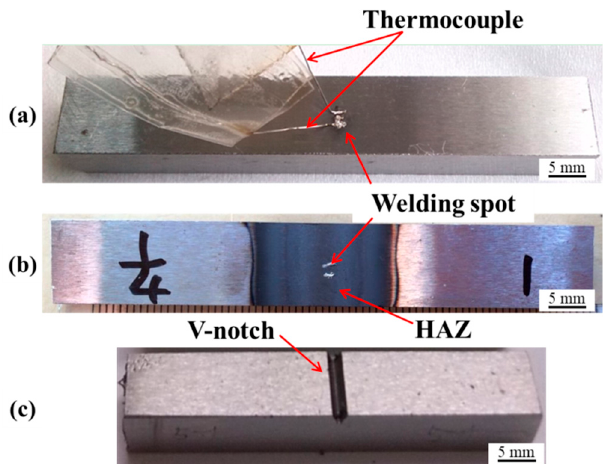
Figure 1. Steel specimens for the simulated high-heat-input welding experiment: ( a ) before welding, ( b ) after welding, and ( c ) the Charpy V-notch impact test. HAZ, heat-affected zone.